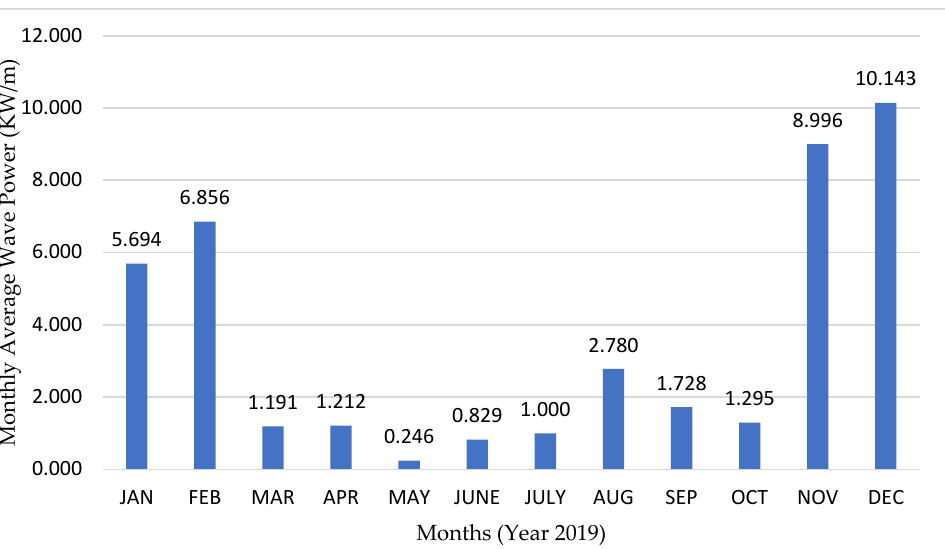
Figure 7. Monthly Average Wave Power in Mantanani Island.